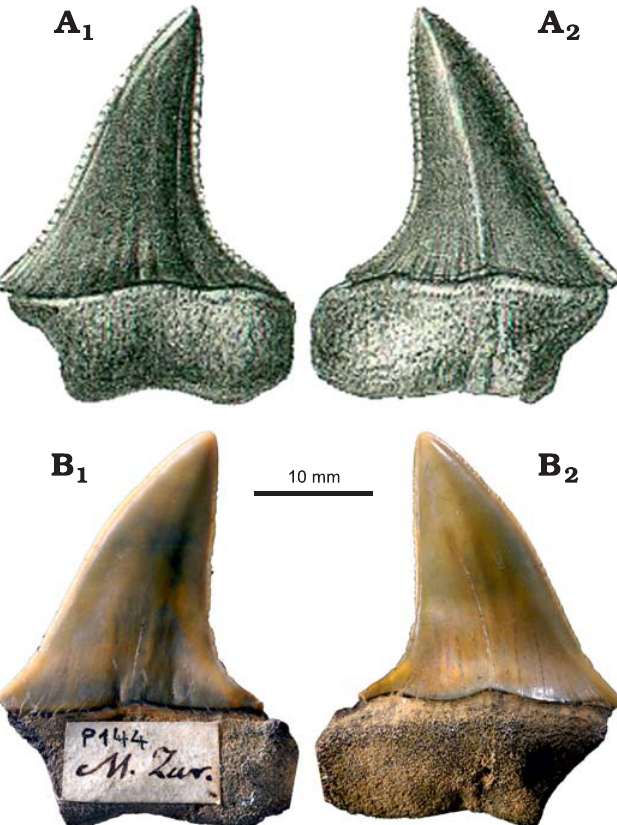
Fig. 4. Holotype of the mackerel shark Car charomodus escheri (Agassiz, 1843) from the Upper Marine Molasse (Burdigalian-Ottnagian,